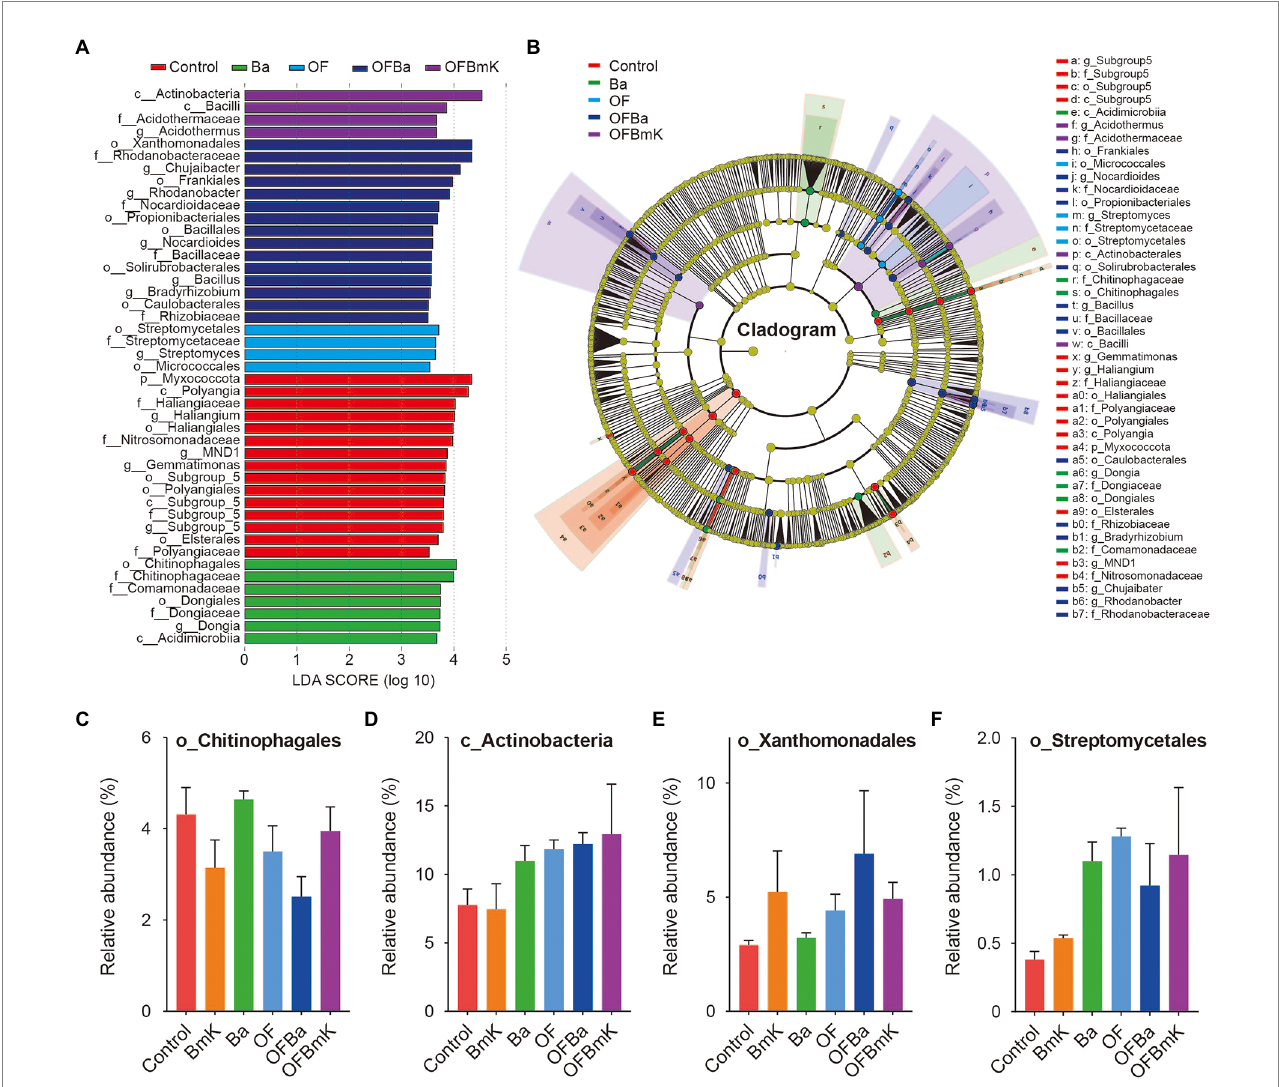
FIGURE 5 Analysis of different microbial species in the soil under different fertilization conditions. (A) Biomarkers associated with the microorganisms present in the soil under different fertilization conditions. Different colored bars indicate species with relatively high abundances in different groups (LDA Score > 3.5). (B) Annotated branching diagram of different microbial species. The yellow nodes represent species that do not differ significantly between treatment conditions. Each section represents a phylum, class, order, family, and genus from the inside out. Relative abundances of the single most abundant biomarkers in the Ba (C) , OFBmk (D) , OFBa (E) , and OF (F)